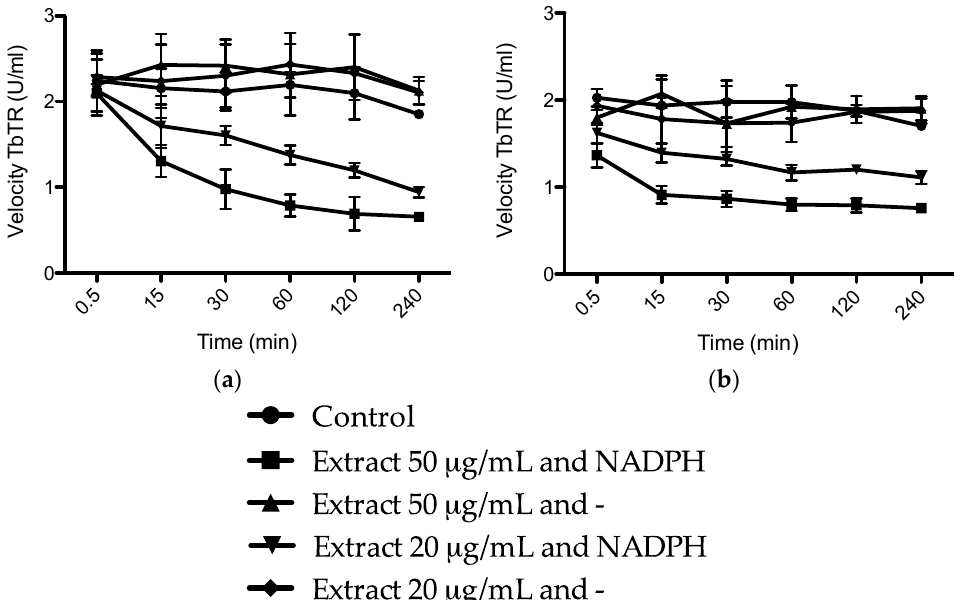
Figure 6. Time course of irreversible inhibition of Trypanosoma brucei trypanothione reductase (TbTR) by 50 and 20 µg/mL of ( a ) Allium ursinum and ( b ) Tulbaghia violacea extracts. Data are shown as mean of three independent experiments ± SD.